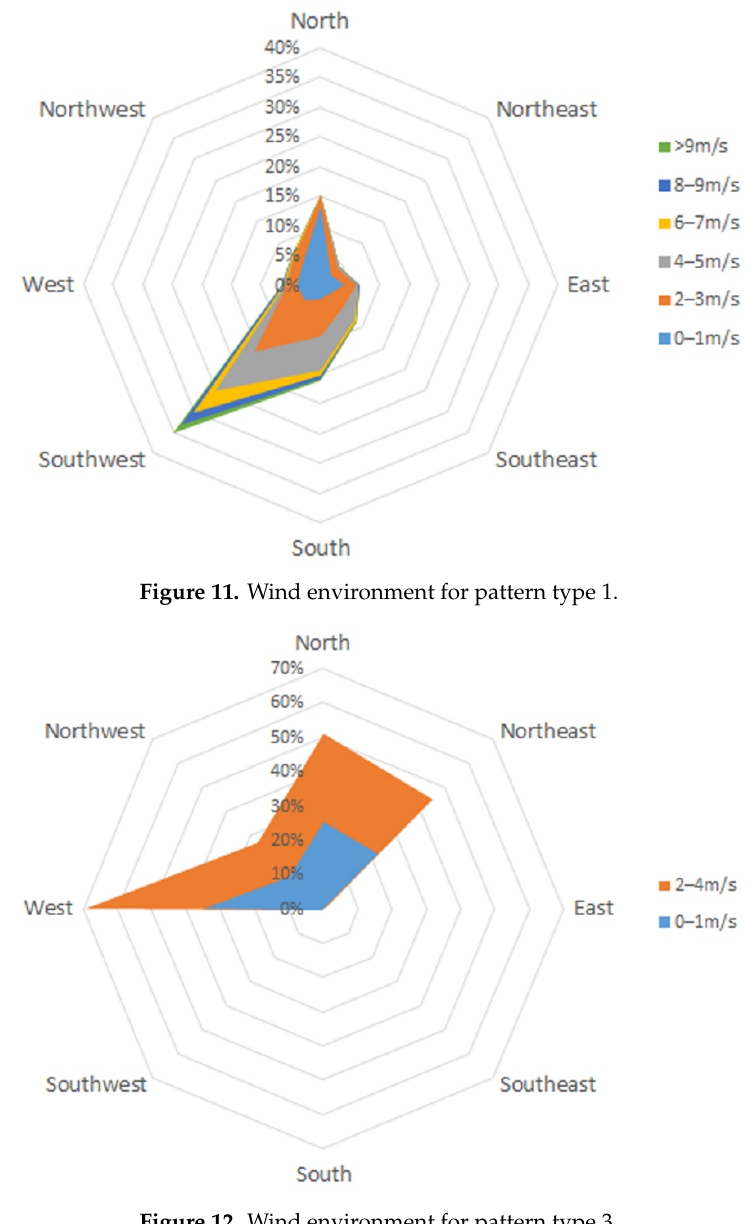
Figure 12. Wind environment for pattern type 3.